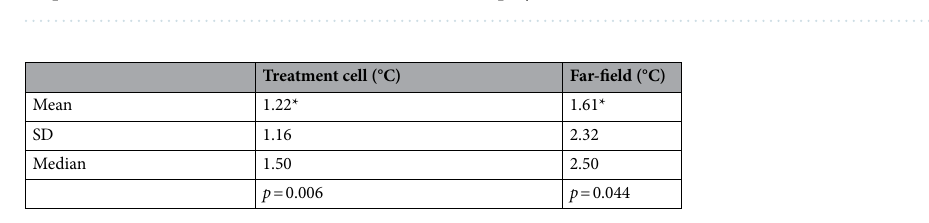
Figure 5. ( a ) Maximum temperature map overlaid on coronal plane perpendicular to the beam axis mid tumor and ( b ) in the far-field region. Values represent the temperature model taken at t = 14 min, or the end of therapy. Voxel time courses that did not have a statistically significant linear fit were set to transparent voxels. Parametric maps were median filtered (3 × 3 kernel) for visual display.